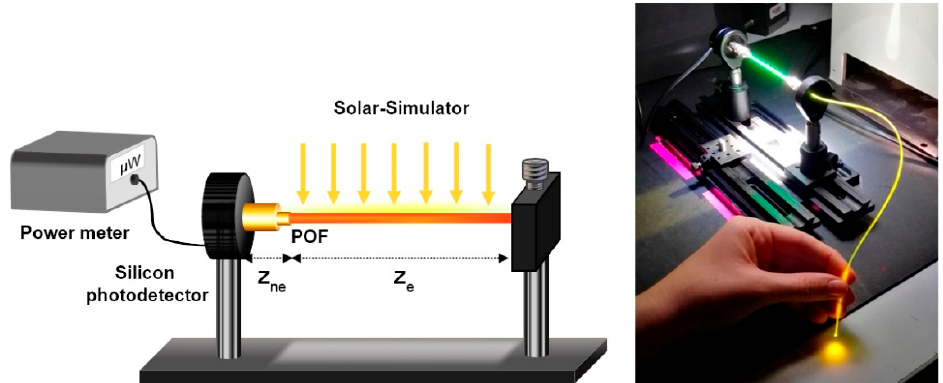
Figure 2. Photographs of the solutions before ( left ) and after ( right ) polymerization under environmental lighting and UV excitation.